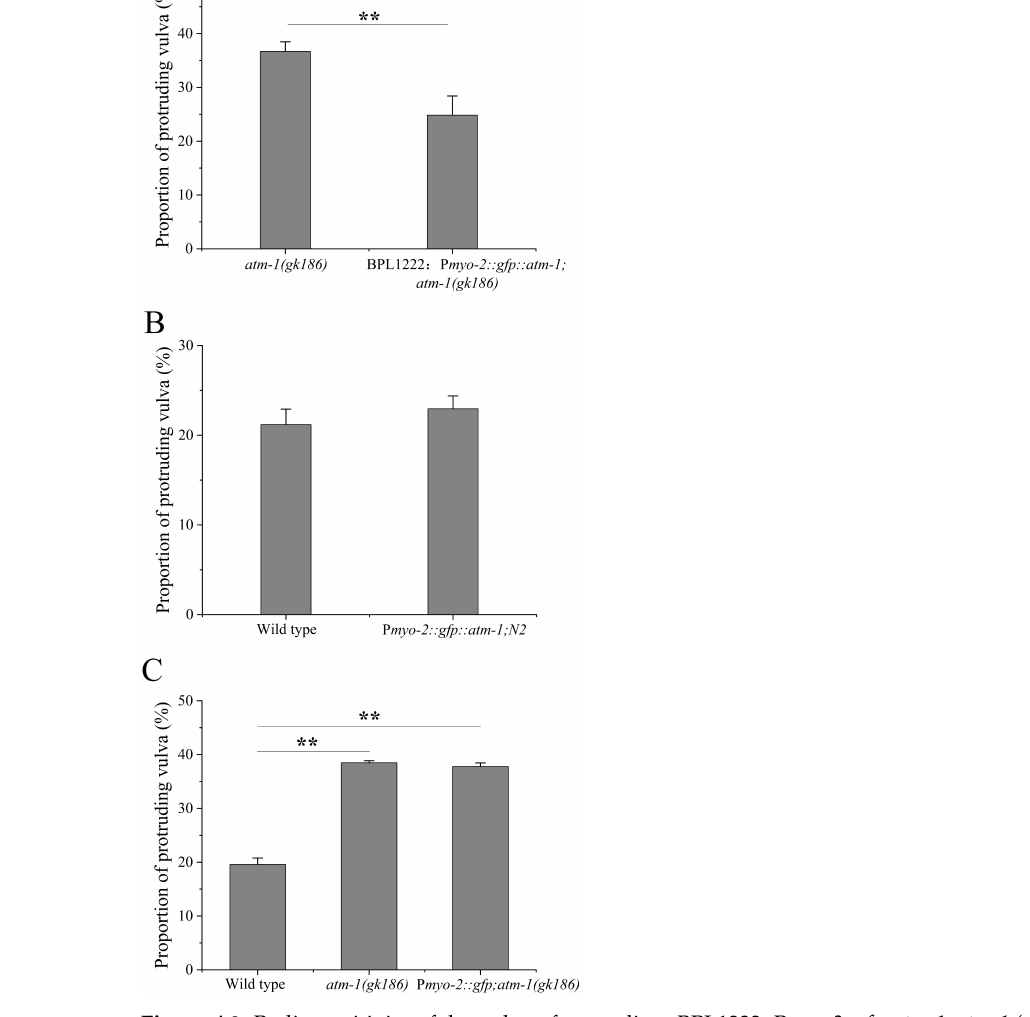
Figure A3. Radiosensitivity of the vulva of worm lines BPL1222: P myo-2::gfp::atm-1; atm-1 (gk186) ( A ), BPL1211: P myo-2::gfp::atm-1; N2 ( B ), BPL1201: P myo-2::gfp; atm-1(gk186) ( C ). Results are means ± SD